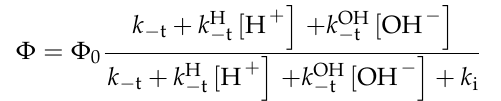
Table 1. Complete sets of thermodynamic and kinetic rate constants characterizing the multistate of the pigments investigated in this work.